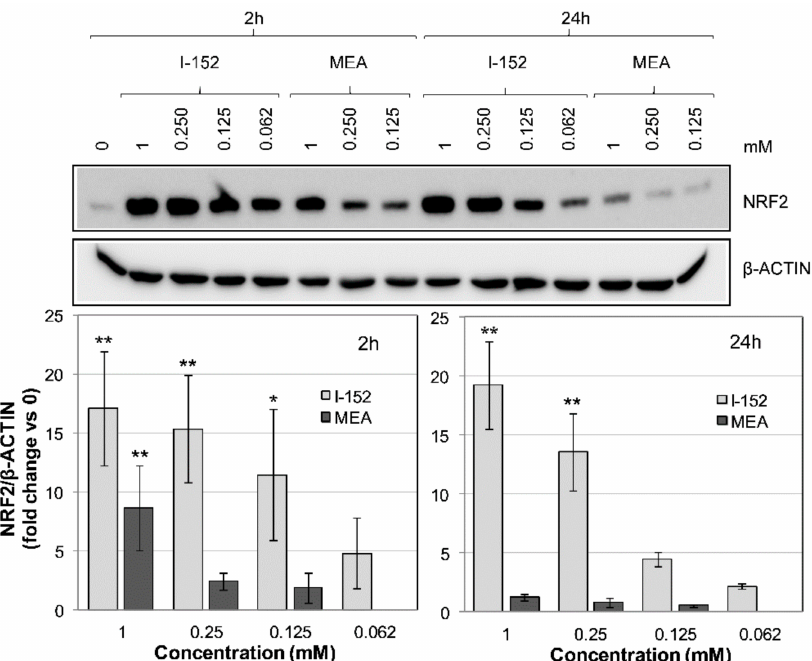
Figure 2. NRF2 levels in I-152- versus MEA-treated RAW 264.7 cells. Cells were treated with different concentrations of I-152 and MEA for 2 h and 24 h; control cells received only fresh medium (0). Whole cell lysates (10 µ g) were separated on 8% ( w/v ) SDS-polyacrylamide gels and analyzed by immunoblotting using an antibody against NRF2. β -ACTIN was stained as a control. Immunoreactive bands were detected in a Molecular Imager and quantified with the Image Lab software. NRF2 levels, normalized to β -ACTIN content, are reported in the graph as fold change relative to control (0). Values are the mean ± SD of at least three independent experiments. * p < 0.05, ** p <